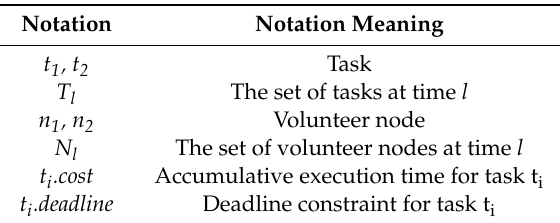
Table 1. Summary of